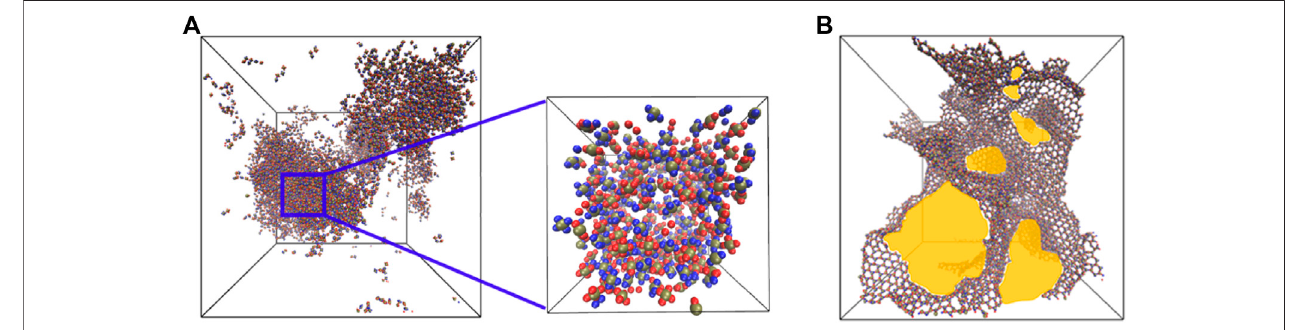
FIGURE 2 | (A) A snapshot highlighting the interstitial pores formed in three-dimensional aggregates. The zoomed-view shows a cube carved out of larger aggregatesandusedinthecalculationofthesizesofinterstitialpores. (B) Asnapshothighlightingtheintra-networkpores(yellow)observedinself-assembledstructures.